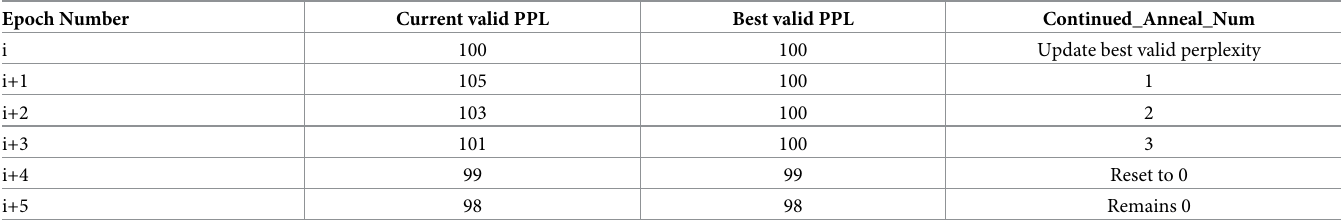
Table 5. An example of Continued_Anneal_Num equals